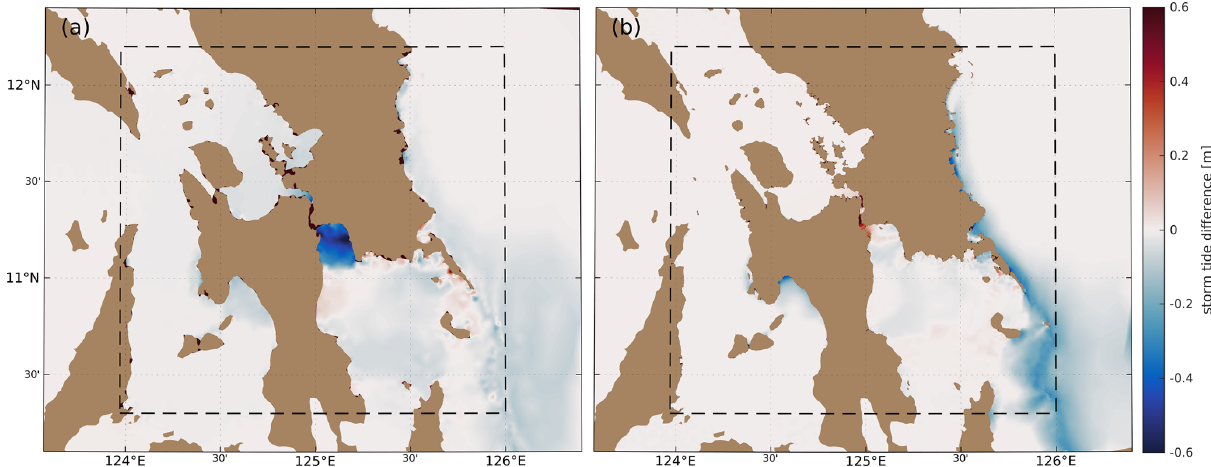
Figure 13. Mesh-resolution-induced differences in the simulated maximum storm tide elevations due to Super Typhoon Haiyan in the Leyte and Samar Island, Philippines, landfall region. (a) Elevations on the MinEle = 500m local refinement mesh minus elevations on the TLS-B global mesh (MinEle = 1.5km). (b) Elevations on the MinEle = 150m local refinement mesh minus elevations on the MinEle = 500m local refinement mesh. In areas where the coarser-resolution mesh does not exist the value shown is just the maximum storm tide elevation on the higher-resolution mesh.